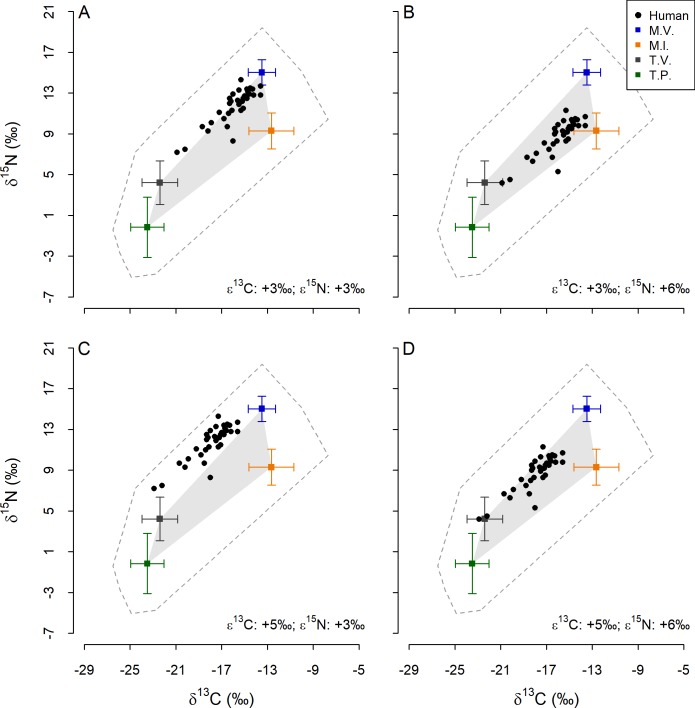
Isotope ratios of Later Stone Age humans and food groups from the Cape Peninsula.Symbols denote humans and food groups as indicated in the legend. The dashed grey outline indicates the minimum convex polygon around all raw values and the solid grey polygon the minimum convex polygon around mean values for food groups. Squares and error bars show mean values and standard deviations for each group. T.P. = terrestrial plant, T.V. = terrestrial vertebrate, M.I. = marine invertebrate and M.V. = marine vertebrate.